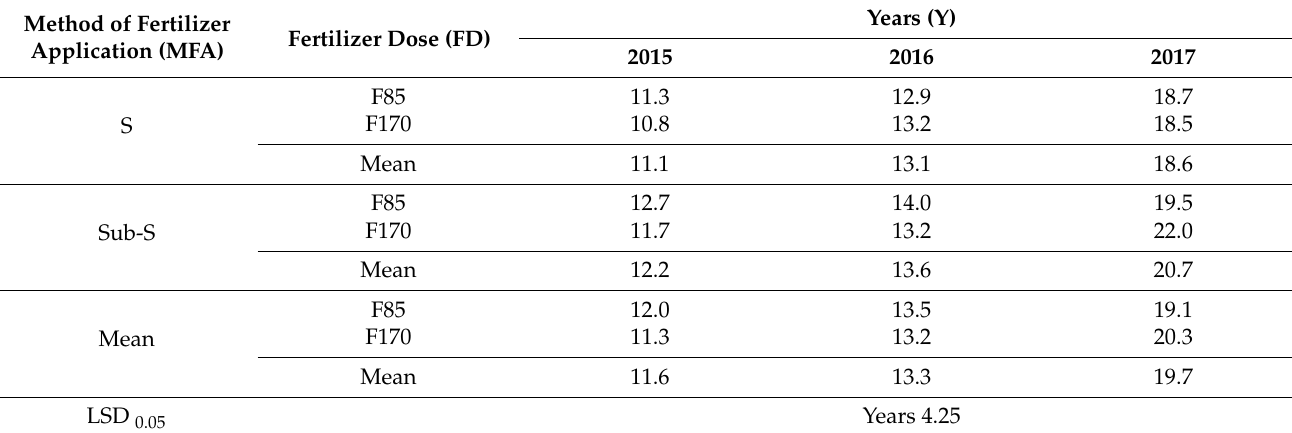
Table 5. Soil organic carbon content in the 0–30 cm soil layer after soybean harvest (g · kg − 1 ). Method of Fertilizer Fertilizer Dose Application (MFA)